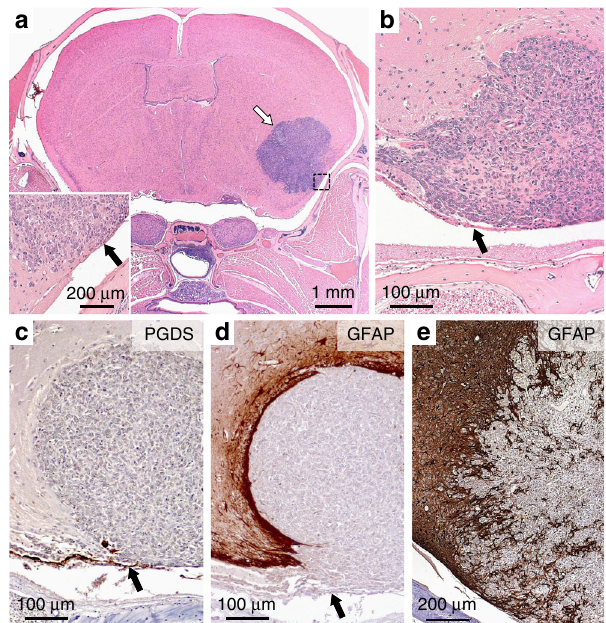
Fig. 2 P0-CreC;Smarcb1 fl ox/ fl ox mice develop RTs in the meninges. a Supratentorial tumors ( white arrow ) were found predominantly located in the subarachnoid space ( black arrow, inset ) with extension into the brain parenchyma. Inset represents a higher magni fi cation of the dashed square area . b Detail of a tumor originating from the meninges. The arrow shows the arachnoid cell layer. c No PGDS staining was found in the tumor as opposed to the arachnoid cell layer ( arrow ). d , e The GFAP staining demonstrated the different degree ( d , non-invasive; e , irregular tumor brain interface consistent with in fi ltration) of invasiveness of the tumors in